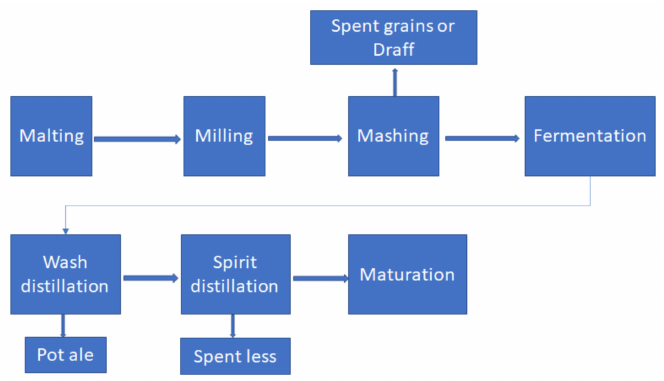
Figure 1. The process of obtaining whisky and the resulting by-products